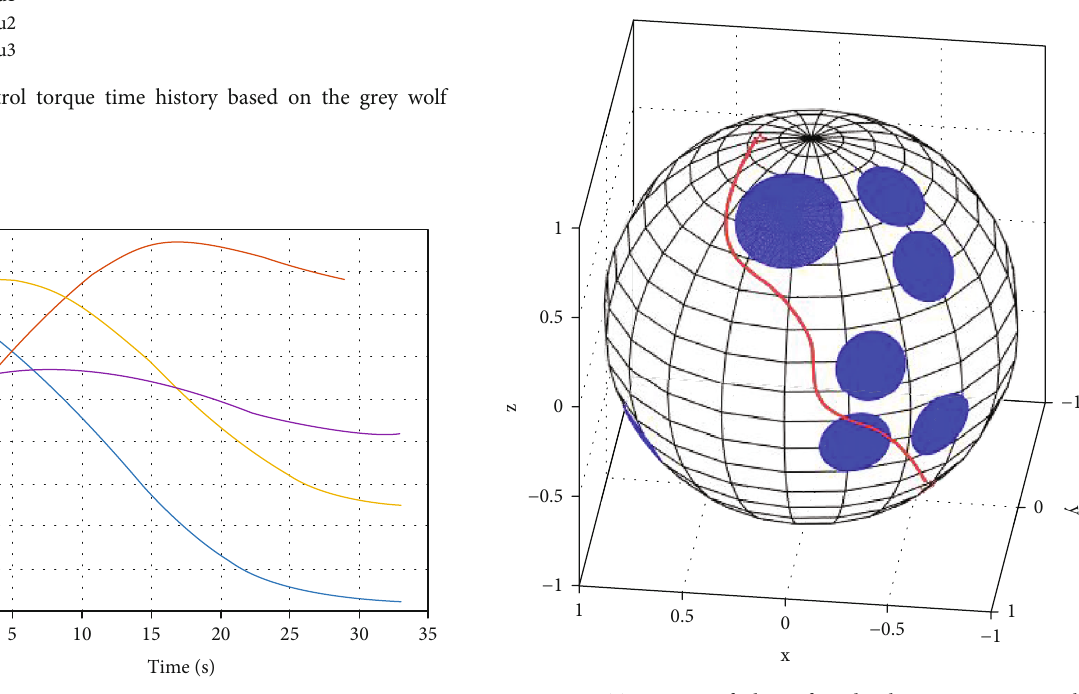
Figure 14: Trajectory of the infrared telescope vector in the celestial coordinate system of the grey wolf